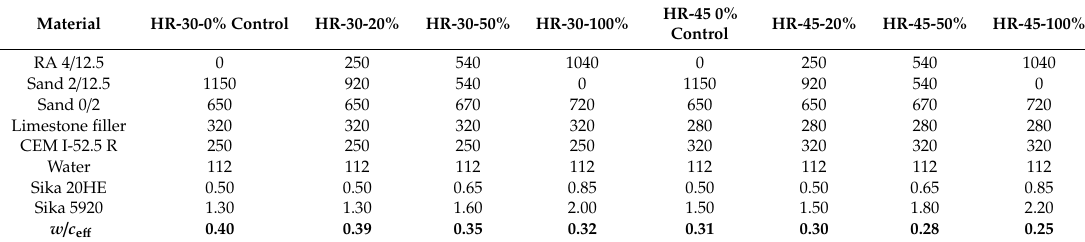
Table 1. Mix proportions of self-compacting concrete (SCC) (kg / m 3 ).